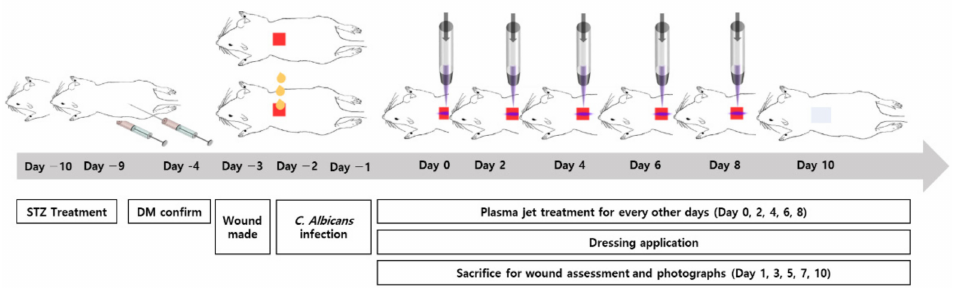
Figure 2. Timeline of C. albicans infected diabetic wound rat modeling and plasma jet